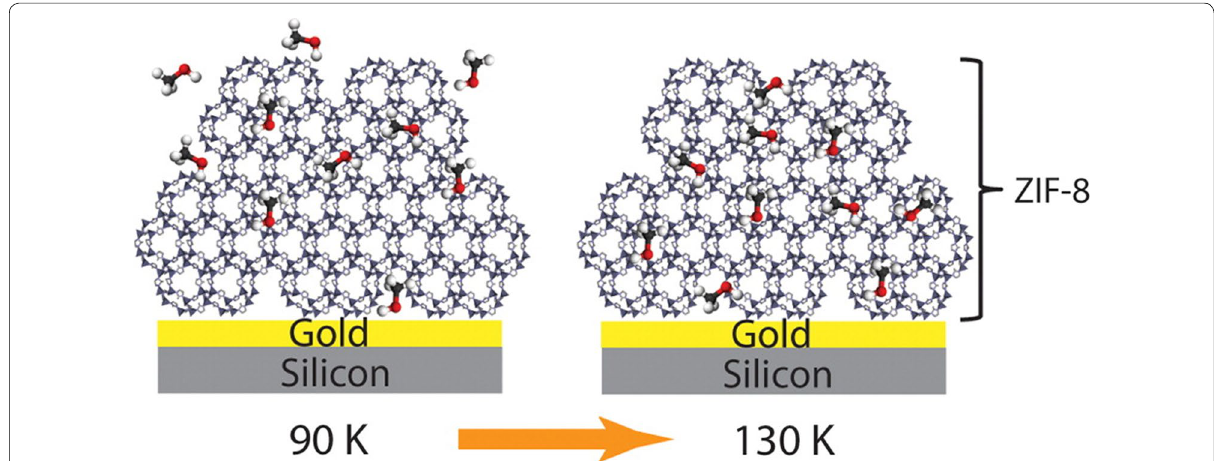
Fig. 8 Ball-and-stick representation of methanol adsorption in ZIF-8 at different temperatures (Reprinted (adapted) with permission from Ref. [78]. Copyright 2016 American Chemical